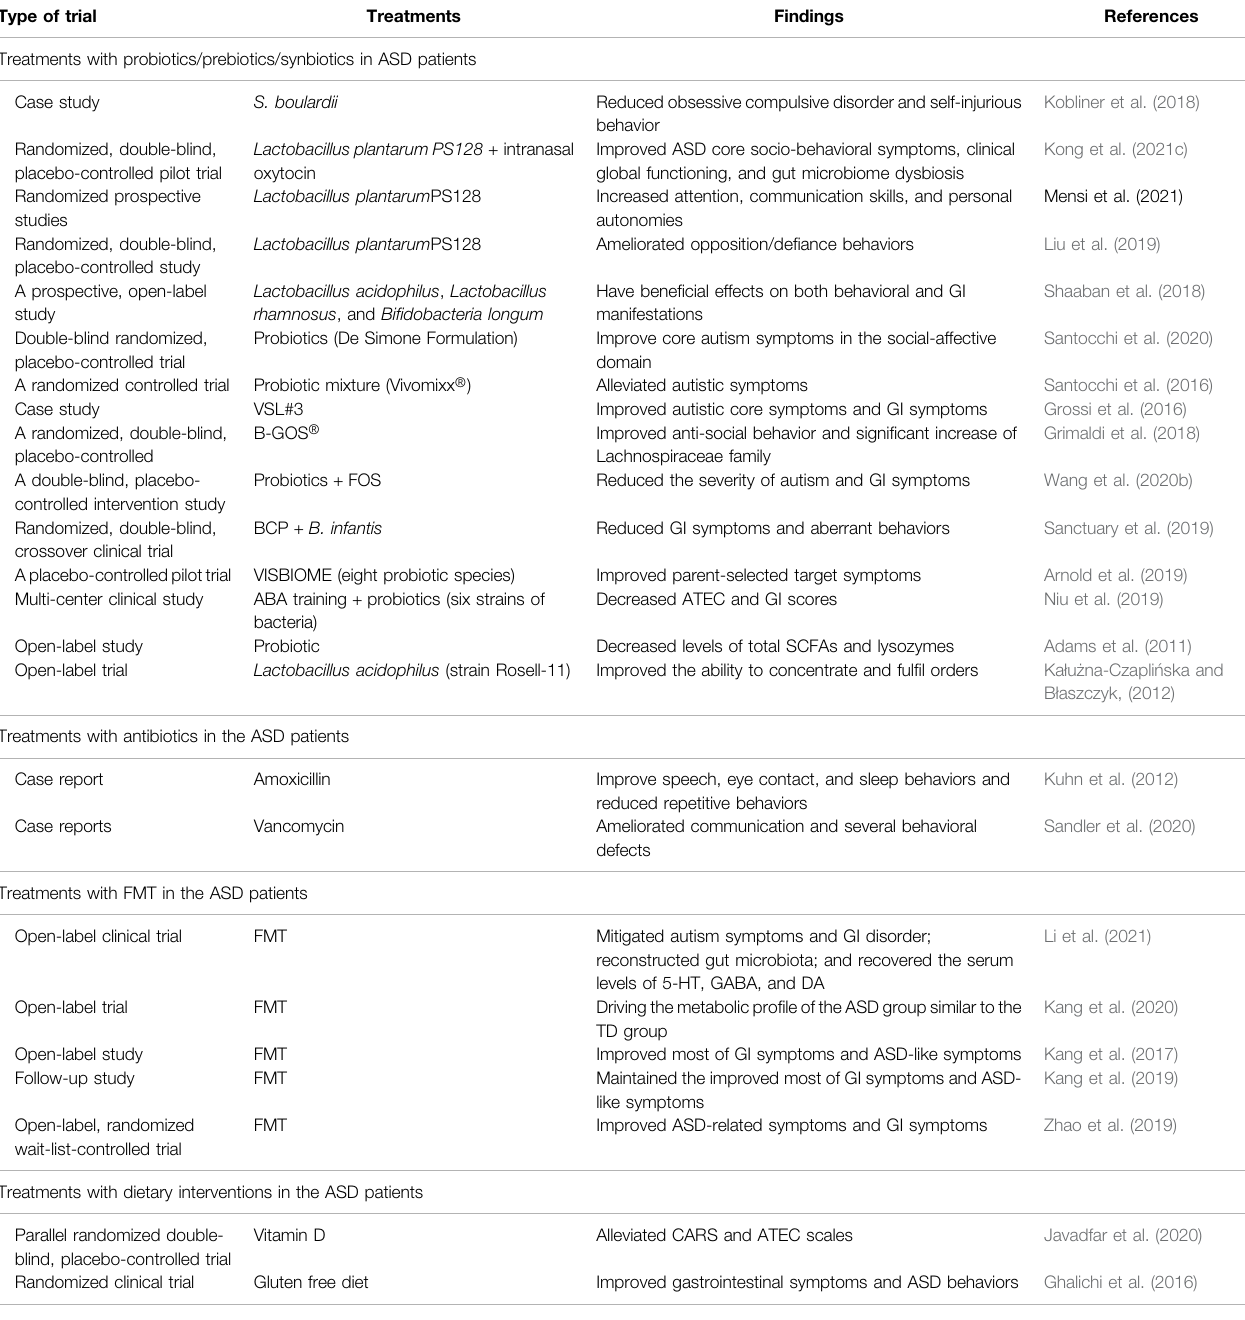
TABLE 3 | Microbial-based therapeutic interventions in ASD